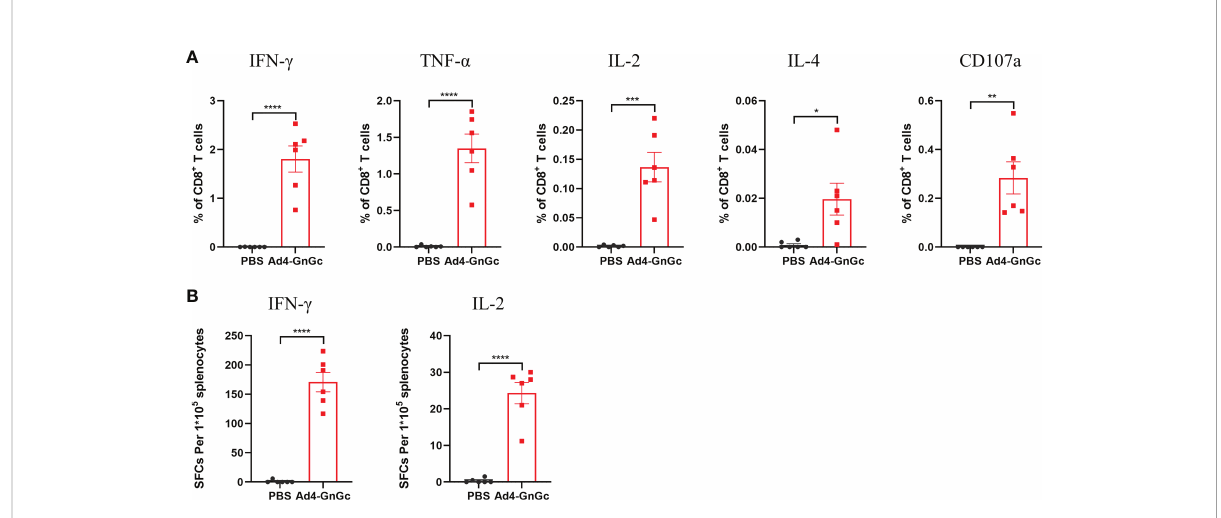
FIGURE 3 RVFV-speci fi c T-cell immune response in Ad4-GnGc-vaccinated mice. BALB/c mice (n = 6) were immunized intramuscularly with a single dose of 10 8 IFU of Ad4-GnGc or PBS. Two weeks after vaccination, the mice were sacri fi ced, and splenocytes were collected. (A) The percentages of CD8 + T cells secreting IFN- g , TNF- a , IL-2, IL-4 or CD107a were determined by ICCS. (B) An ELISPOT assay was performed to assess IFN- g and IL-2 secretion by mouse splenocytes. Data are shown as the mean ± SEM. P values were analyzed with an unpaired Student ’ s t test. * P < 0.05, ** P < 0.01, *** P < 0.001, **** P <